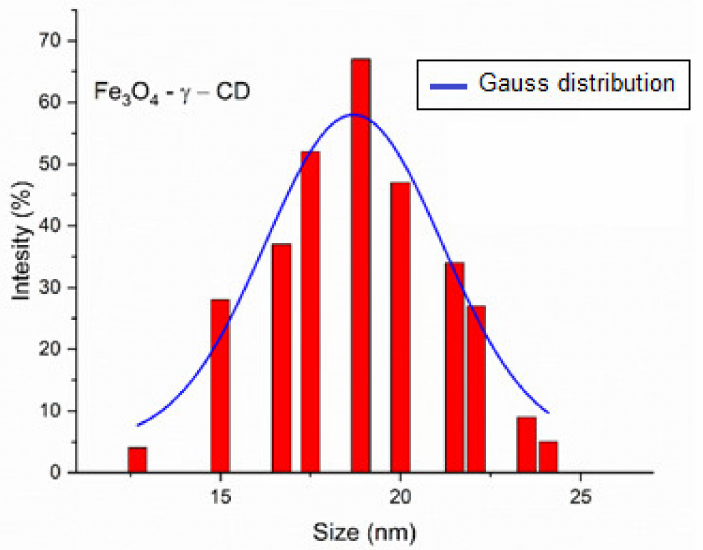
Figure 12. DLS for Fe 3 O 4 -PAA–(HP- γ -CDs)